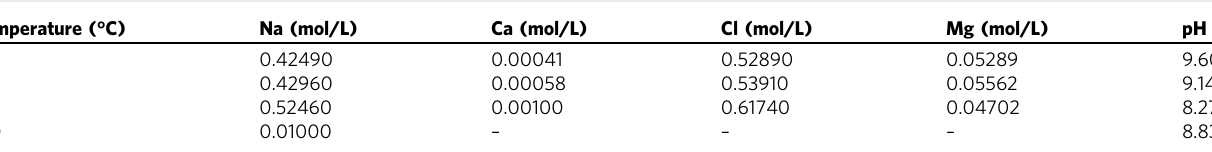
Table 2 Water chemistry of reaction fl